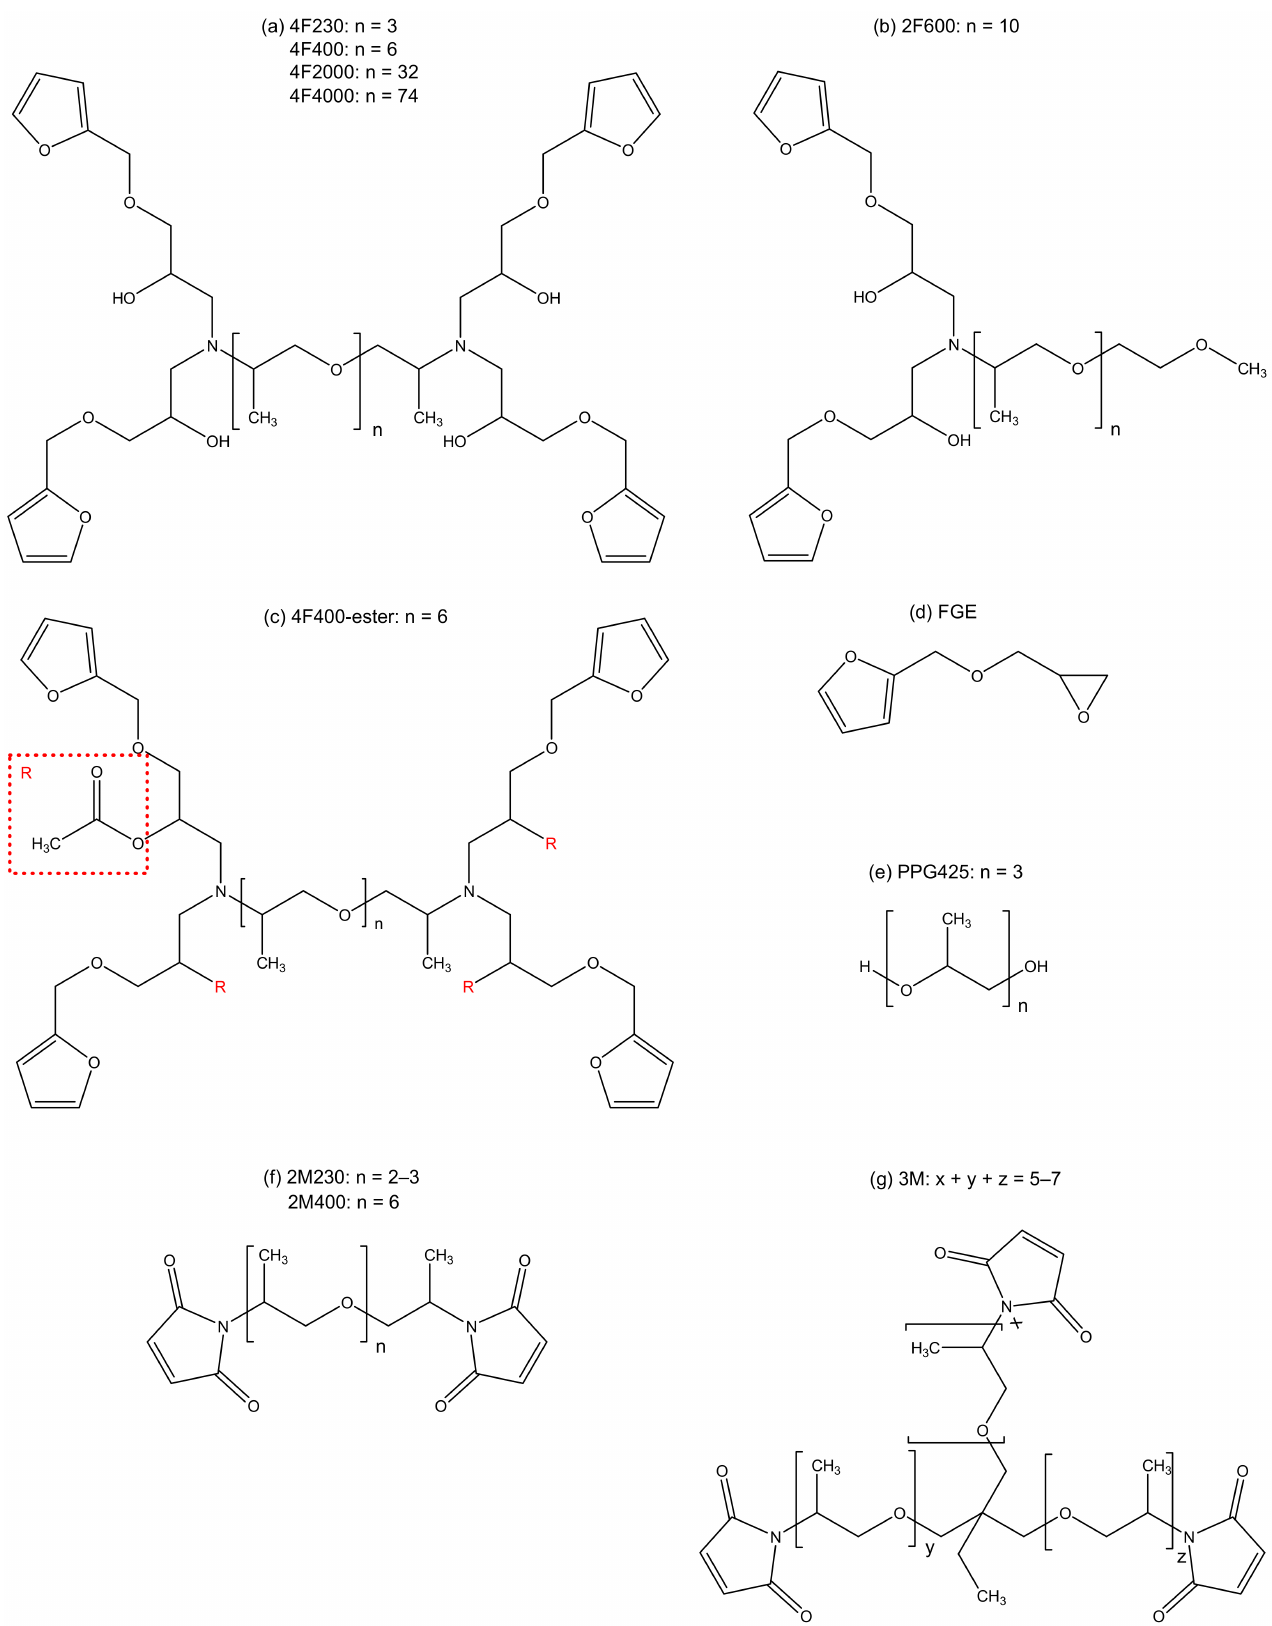
Figure 2. Furan and maleimide compounds for the kinetic